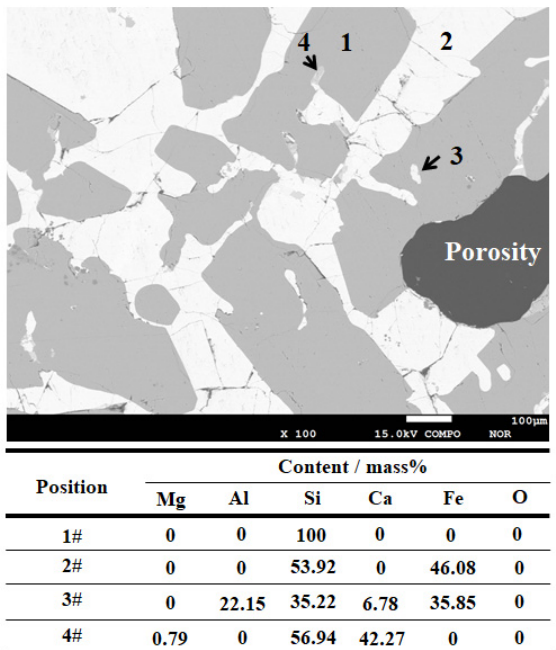
Figure 5. Microstructure of the Fe – Si alloy.